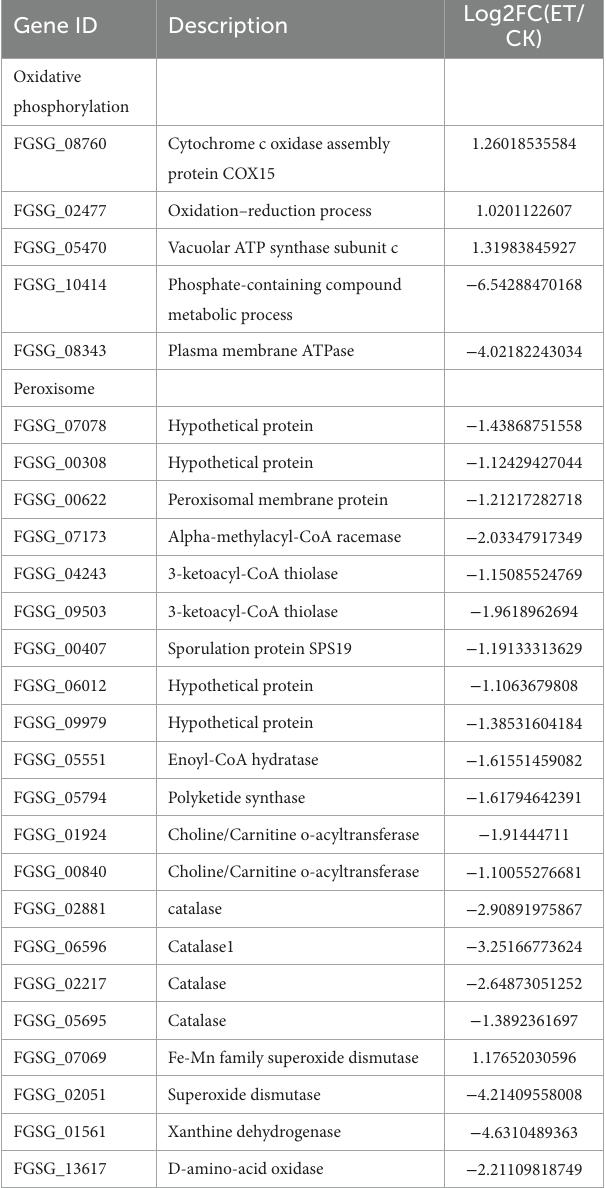
TABLE 5 DEGs associated with oxidative phosphorylation and